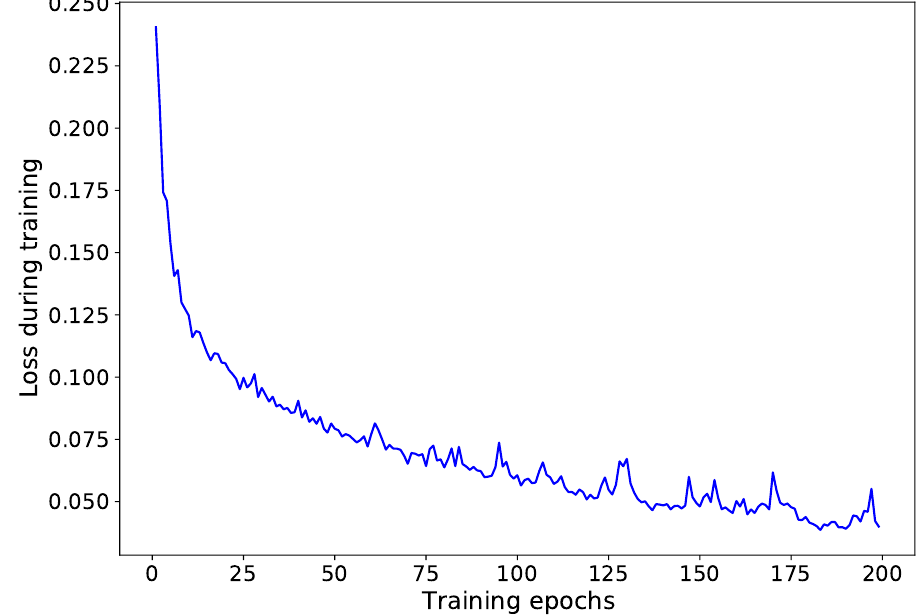
Figure 5. Loss curve during training with the NC_A167E1 one-month dataset.